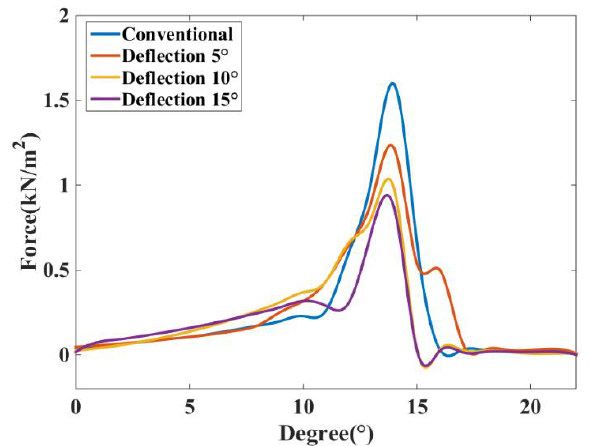
Figure 15. Radial force distribution under different deflection angles.